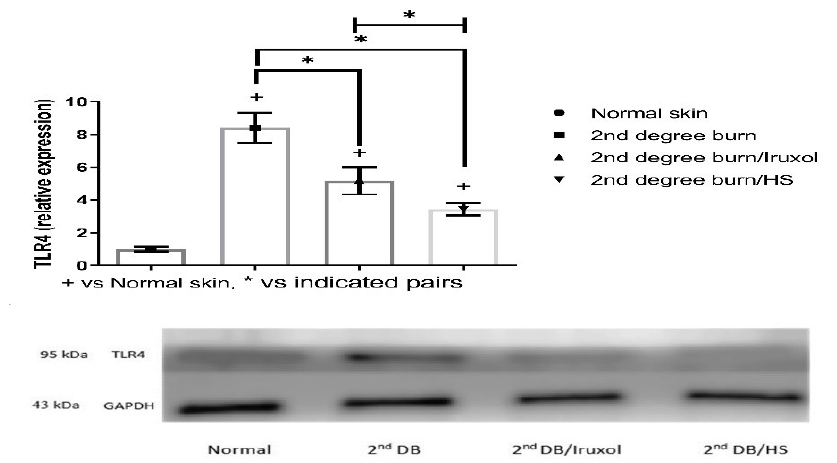
Figure 8. Effect of HS on Toll-like receptor 4 (TLR4) expression in different groups. TLR4: Toll-like receptor 4; HS: Hibiscus sabdariffa; +, p < 0.05 vs. normal group; *, p < 0.05 vs. 2nd degree burn group. Group differences were examined by ANOVA/Tukey/Kramer’s multiple comparison test. n = 6.